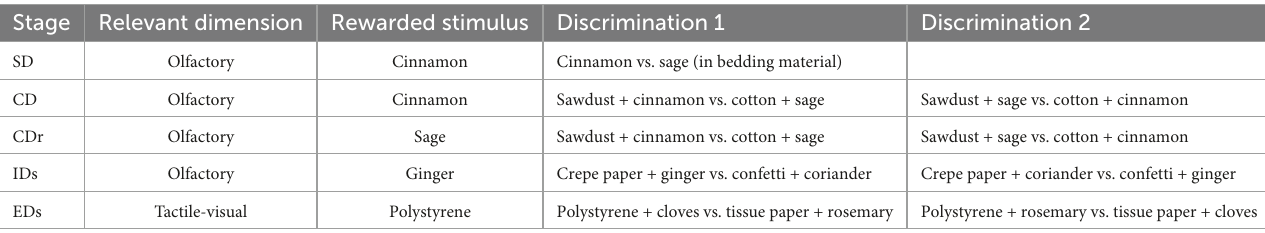
TABLE 2 Stimulus exemplars used in the Attentional set-shifting task (ASST).